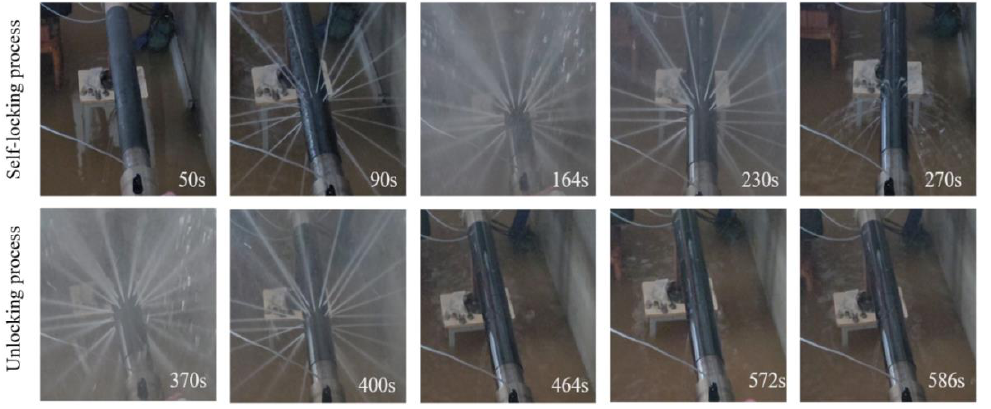
Figure 20. Experimental phenomena of Experiment IV.